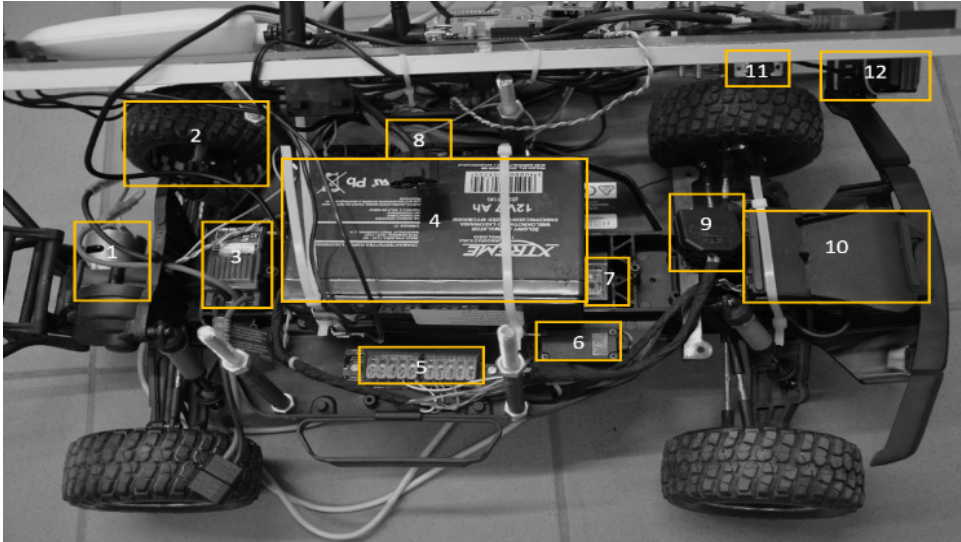
Figure 4. The arrangement of individual modules below the top board of the mobile platform.